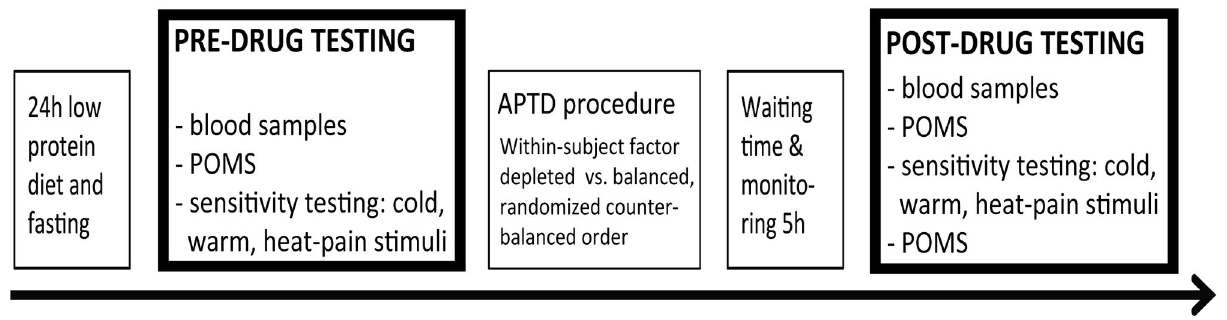
Figure 2. Overview of the time course of an experimental session of Study 2. All participants performed two sessions. In both sessions, participants ingested encapsulated amino acids and an amino acid mixture; in one session this mixture did not contain phenylalanine and tyrosine (depleted) while in the other session it contained these amino acids (balanced) as a control condition. In each session, participants performed pre- and post-ingestion testing, separated by a 5h waiting period. doi: